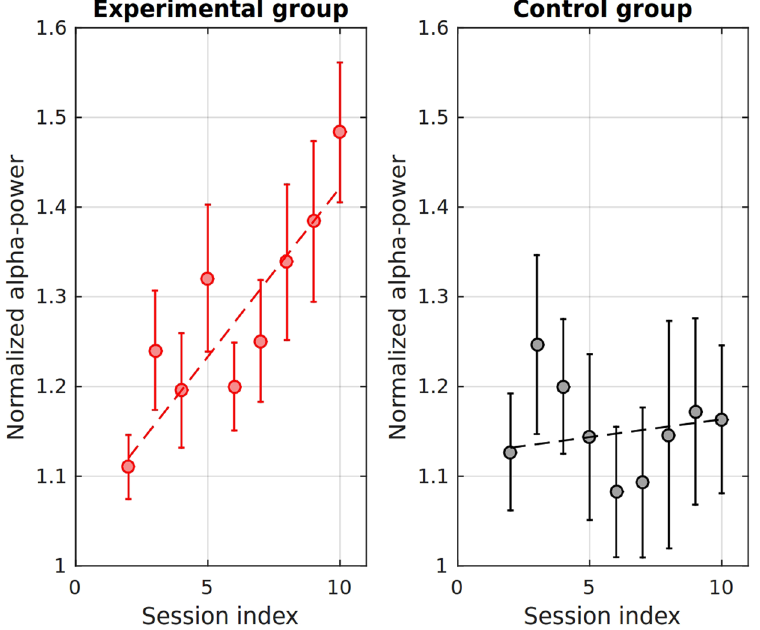
Figure 3. Average P4-alpha power dynamics in the experimental and the control groups during the two days of training. The points on the graph represent the mean alpha power during each 2-minute neurofeedback session relative to the first session of the first day. Since the first session of the first day was used as a reference point and is omitted from the graphs (baseline = 1), the effect of each individual 2-minute session can be estimated as a ratio of the observed value to that from the previous